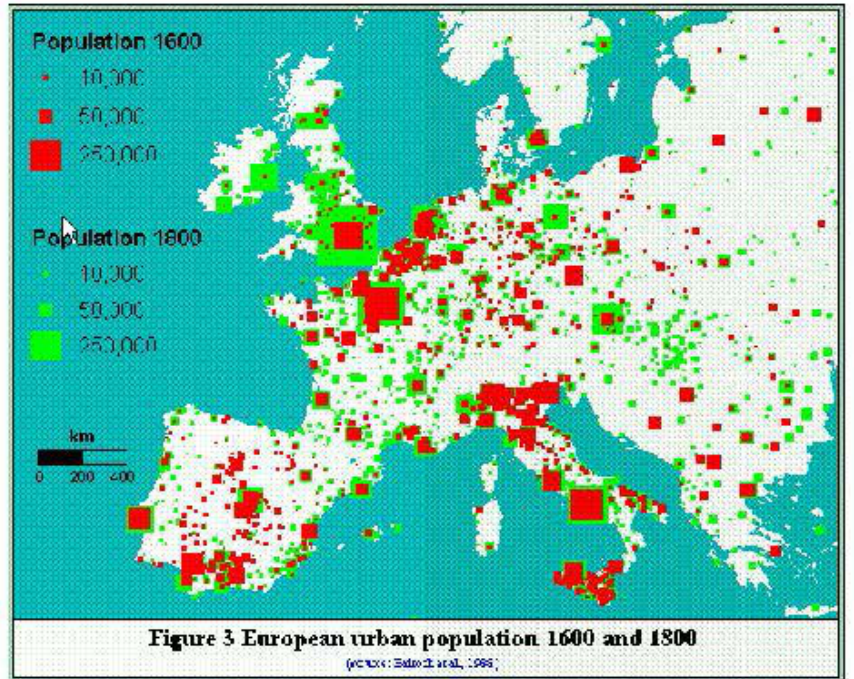
figure:\. The 'boom' ofBritish to-wns between 1600 and 1800 is dearlyvisible as well as the con tinning stllgnation in most of so·nthern Enrope. The development off rench towns was intermediate and diflcren tiated between stllgnating older cities on il, bonlcrs and shores and developing small cities in the